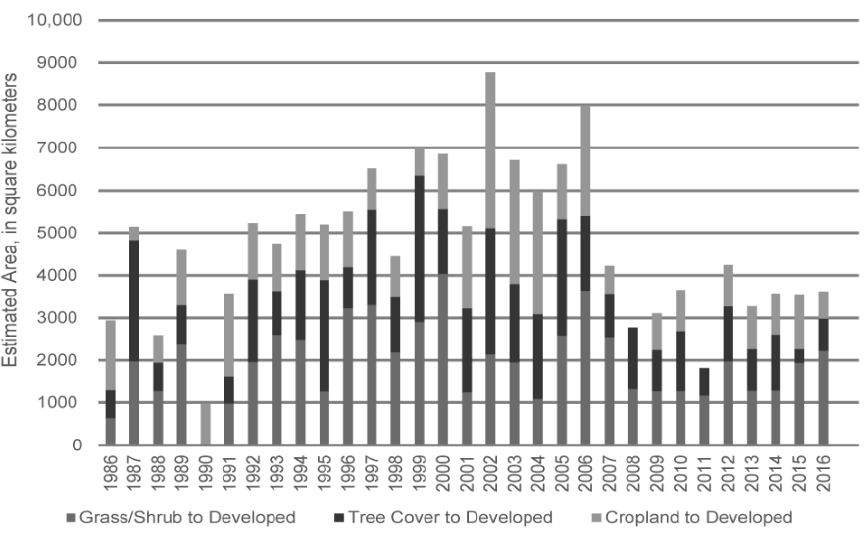
Figure 6. Estimated annual area of major sources of change to developed land cover, 1985–2016, with 1986 “change year” starting on 1 July 1985.